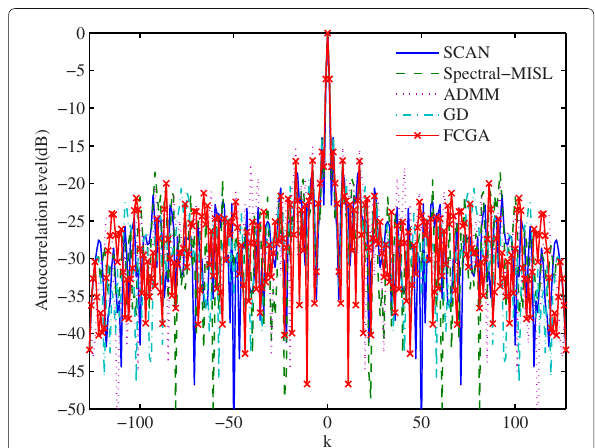
Fig. 8 Autocorrelation level of the sequences generated by five different algorithms